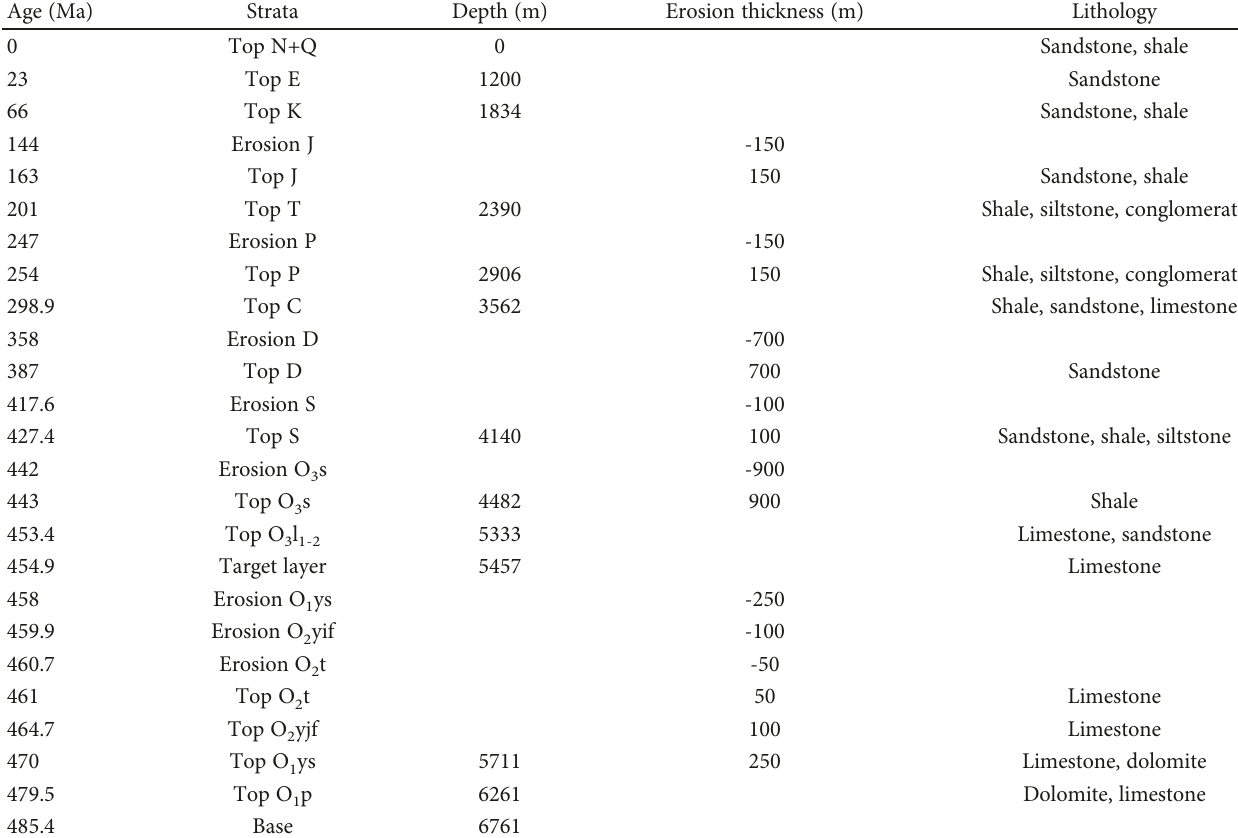
Table 3: The main deposition and erosion events in Well